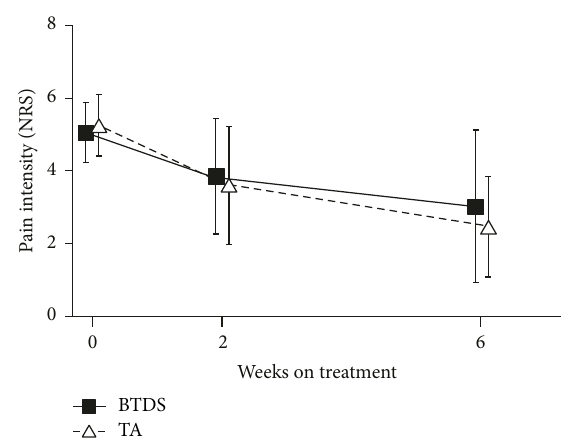
Figure 3: Mean pain intensity scores from baseline to Week 6